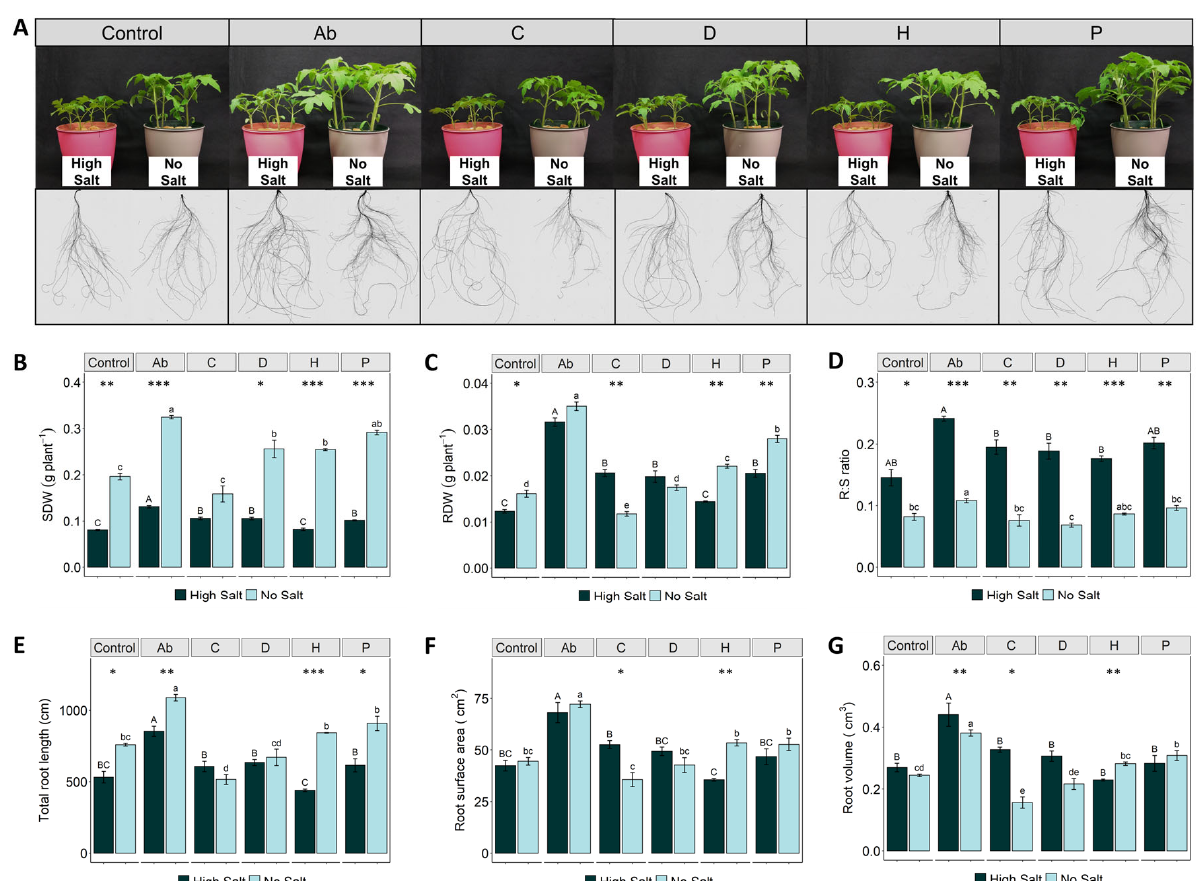
Figure 1. Effects of salt stress (high salt: 120 mM NaCl or no salt: 0 mM NaCl) and biostimulant application (Ab— Azospirillum brasilense ; C— Malvaceae -based; D—Trainer ® ; H—Vegamin ® ; P— Poaceae -based; and Control—distilled water) in the biomass accumulation and root morphology of tomato plants growing in hydroponic conditions. Representative pictures of tomato shoots and roots WinRhizo scans ( A ), Shoot dry weight—SDW ( B ), Root dry weight—RDW ( C ), Root to shoot ratio ( D ), Root surface area ( E ), Total root length ( F ), Root volume ( G ). Values are means ± SE. Capital letters compare treatments under high salt and lowercase letters compare treatments un ‐ der low salt. Equal letters correspond to average values that neither differ according to Tukey’s HSD test ( p < 0.05). Asterisks indicate significant differences between high and low salt, according to Student’s t ‐ test (* p < 0.05; ** p < 0.01, *** p < 0.001).